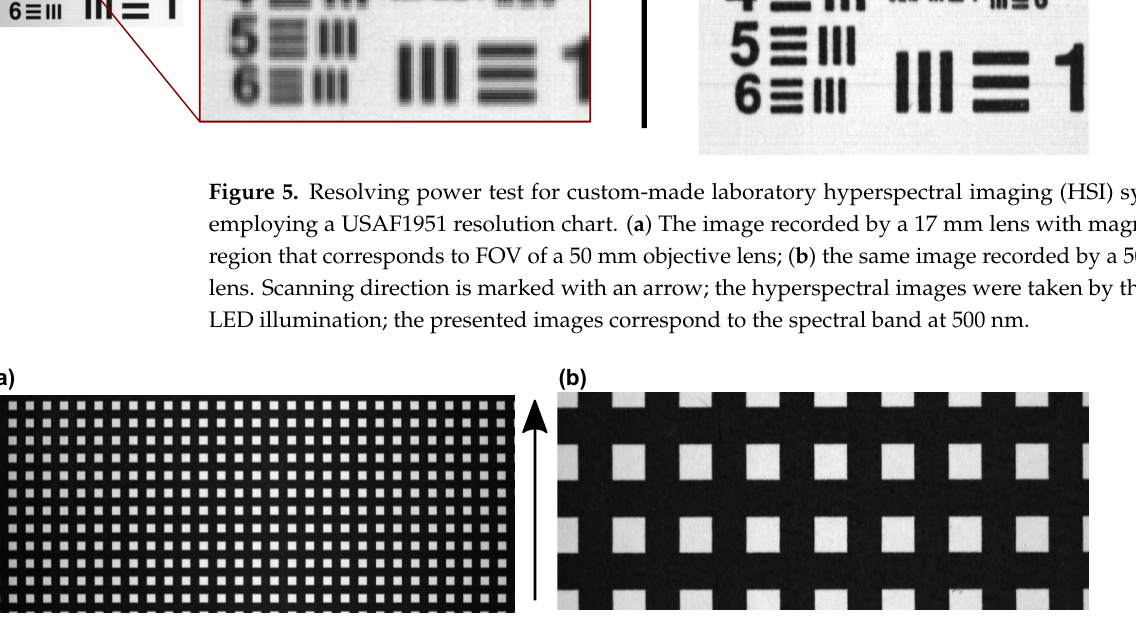
Figure 6. Scanning speed calibration. Images of a 5 mm grid are recorded with ( a ) a 17 mm lens and with ( b ) a 50 mm lens. Direction of the scan is shown with an